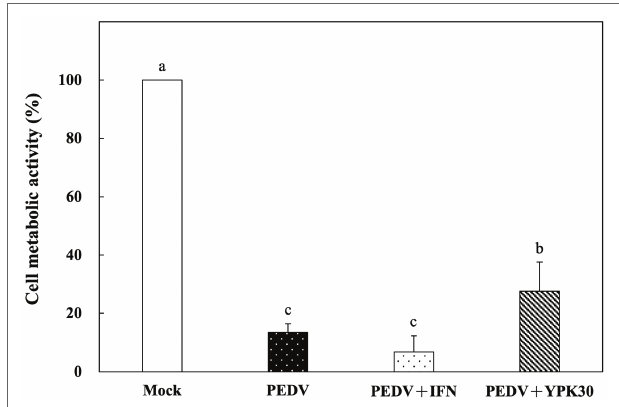
FIGURE 6 | In vitro direct-inhibitory effects of the intracellular extracts of Ln. mesenteroides YPK30 against PEDV infection in Vero cells. Bar chart showing percentage of cell metabolic activity of four sample conditions: (1) Mock: cells incubated with PBS, (2) PEDV: cells infected with PEDV, (3) PEDV+IFN: cells infected with PEDV and simultaneously treated with IFN- α 2b, and (4) PEDV+YPK30: cells infected with PEDV and simultaneously treated with the intracellular extracts of Ln. mesenteroides YPK30. All data are expressed as mean ± SD ( n = 3). Bars marked with the same letter are not significantly different ( p >